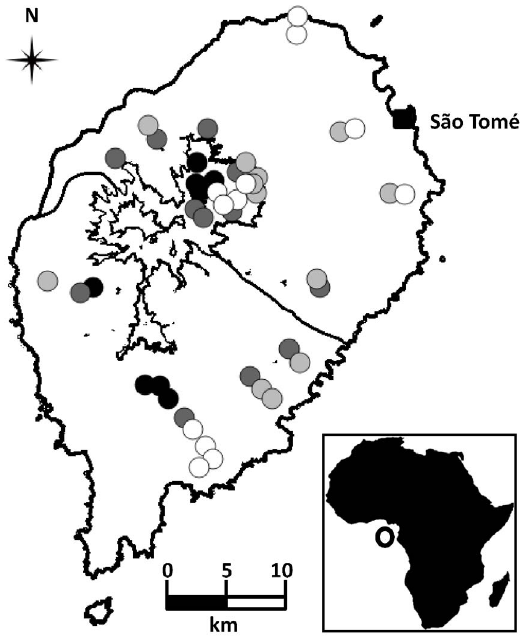
Figure 1. Map of Sa˜o Tome´. The inset in the bottom right shows the location of the island in Africa (hollow dot). The contour lines are showing the three sampling regions: Montane (between 800 and 1400 m a.s.l.), North (up to 800 m a.s.l. and less than 2000 mm of annual rainfall) and South (up to 800 m a.s.l. and more than 3000 mm of annual rainfall). Each dot in the main map represents a transect, which is coloured according to the land-use sampled: black – old- growth forest; dark grey – secondary forest; light grey – shade plantation; and white – non-forested. The capital, Sa˜o Tome´, is signed by a black square.